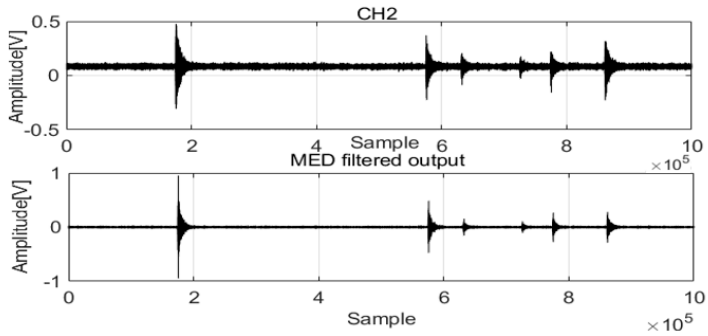
Figure 10. MED method for the acoustic signals in Channel 2.